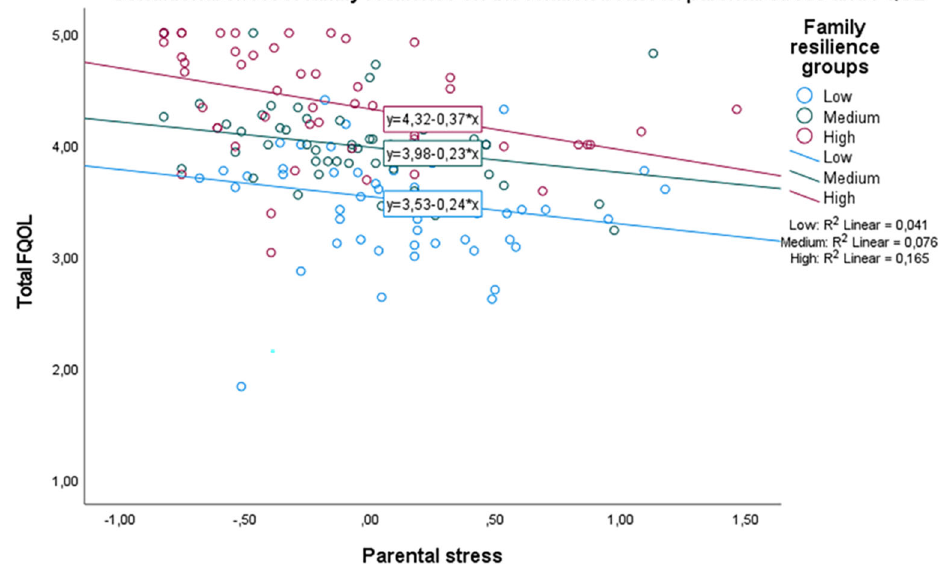
Figure 2. The conditional effect of family resilience on the relation between parental stress and